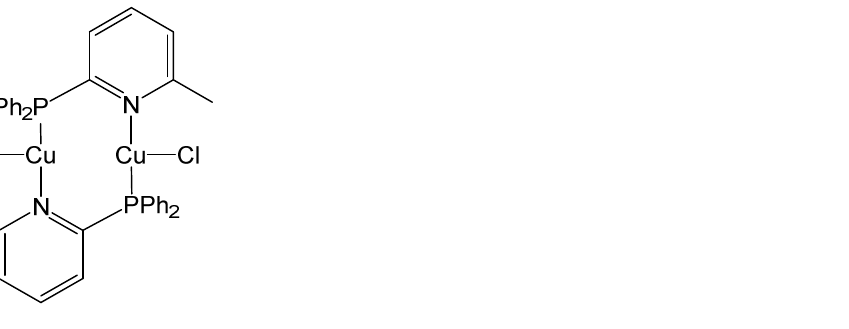
Figure 1. Di-nuclear Cu(I) complex, Cu 2 Cl 2 (P ∩ N) 2 featuring both TADF and phosphorescence [48].